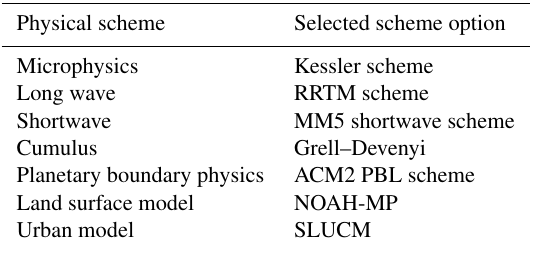
Table 3. Physical parameterization